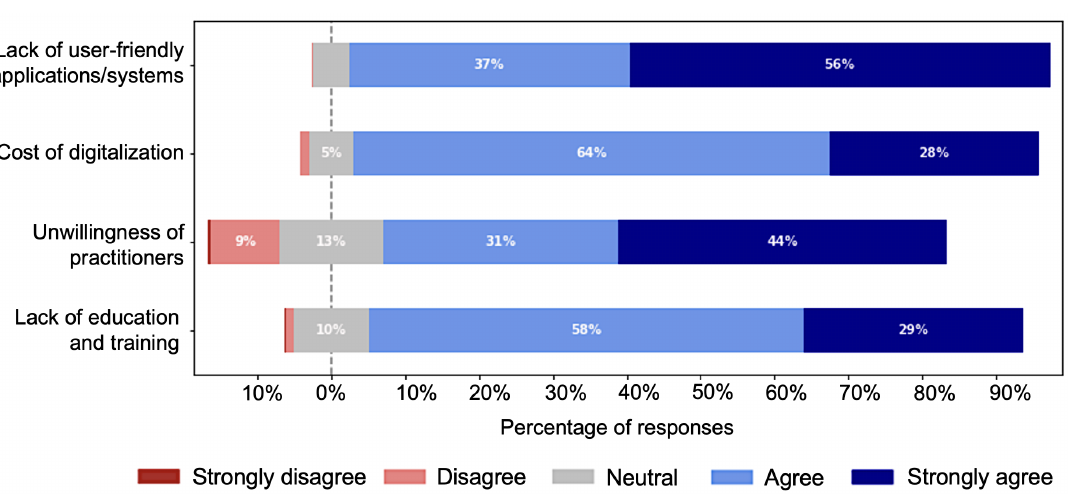
Figure 17. Survey responses on the major challenges for